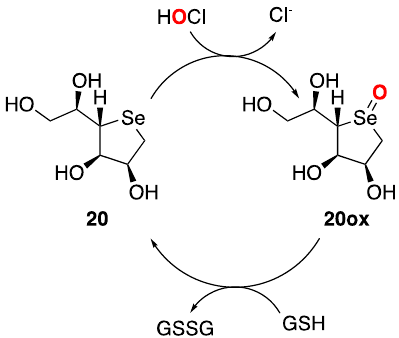
Figure 3. Catalytic cycle of 1,4-anhydro-4-seleno-D-talitol (SeTal) ( 20 ).